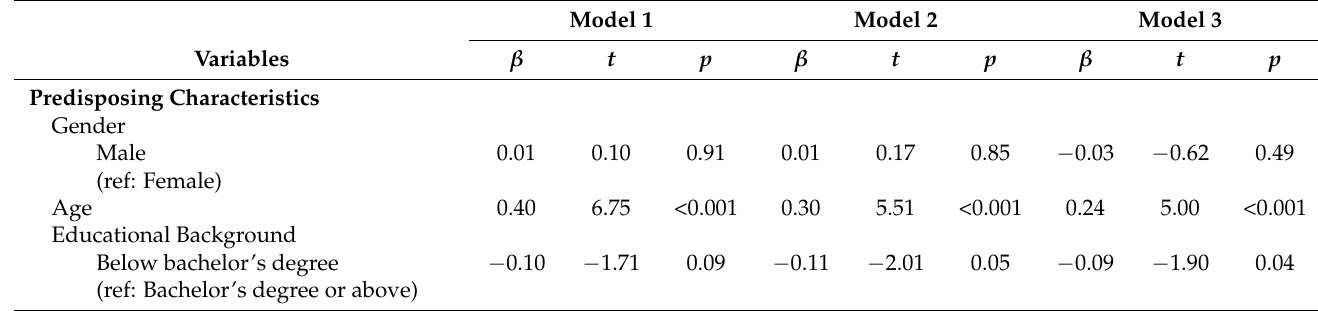
Table 3. Hierarchical Regression Analysis of Factors Influencing the Intended Use of Basic Life